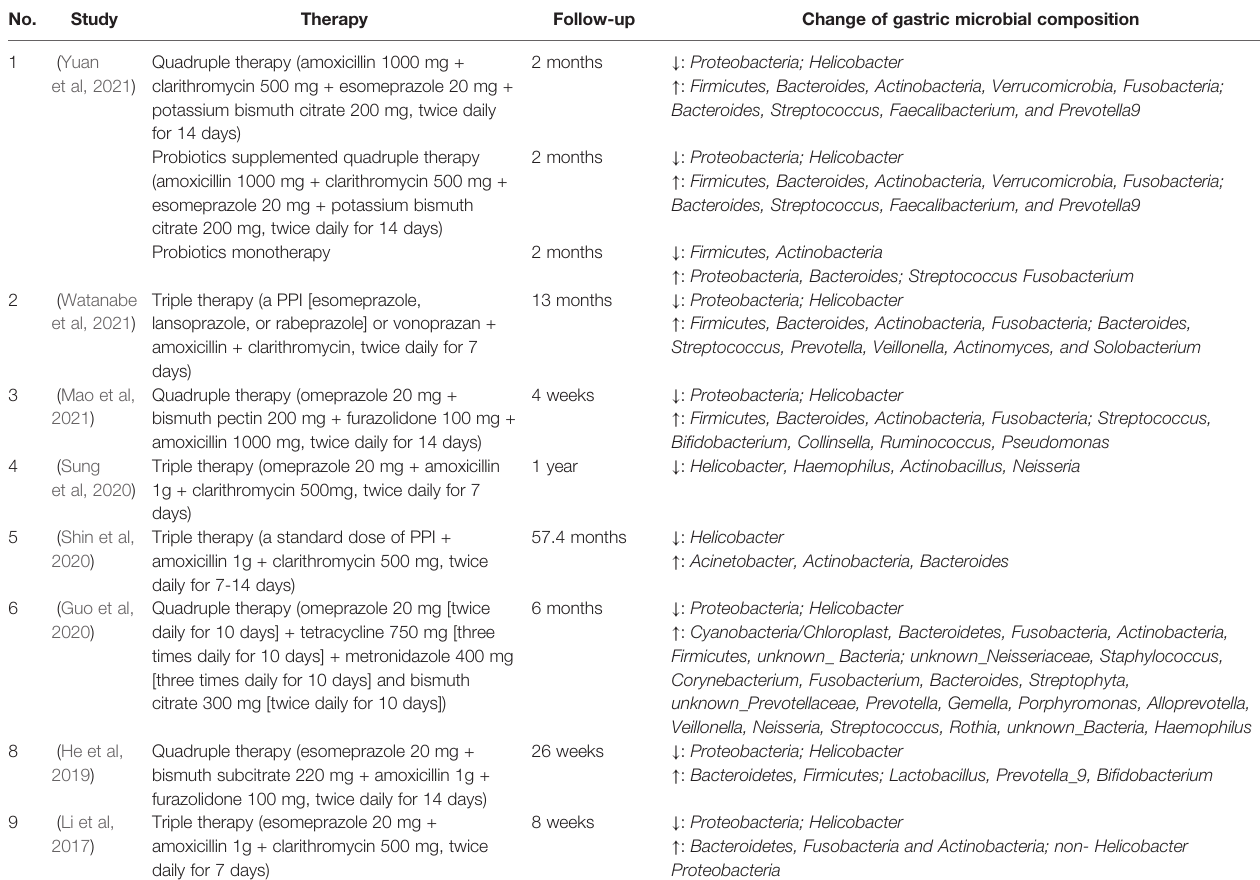
TABLE 3 | Major fi ndings of gastric microbial